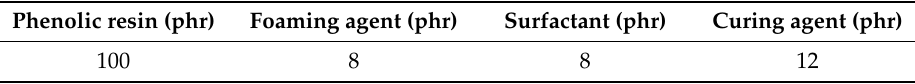
Table 1. The phenolic resin foaming